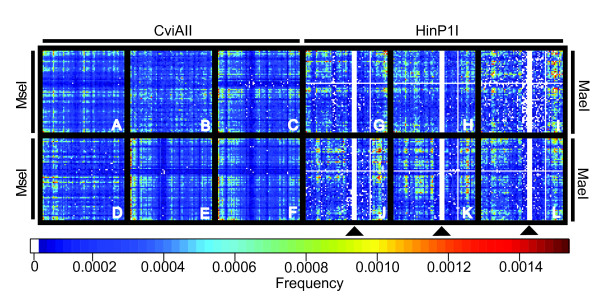
cDNA-AFLP patterning is consistent across all eukaryotes. Arrays of all possible cDNA-AFLP selective PCR combinations for the best (A-F) and worst (G-L) restriction enzyme combinations. Six species per enzyme combination are included. A-F restriction enzymes CviAII and MseI, G-L restriction enzymes HinP1I and MaeI. A/G Arabidopsis thaliana, B/H Drosophila melanogaster, C/I Gallus gallus, D/J Gasterosteus aculeatus, E/K Homo sapiens, F/L Xenopus laevis. Arrowheads pointing to white areas in the arrays indicate primer combinations with GCN-selective base pair motifs, which fail to produce any fragments in a cDNA-AFLP screen with these enzymes (see Discussion).